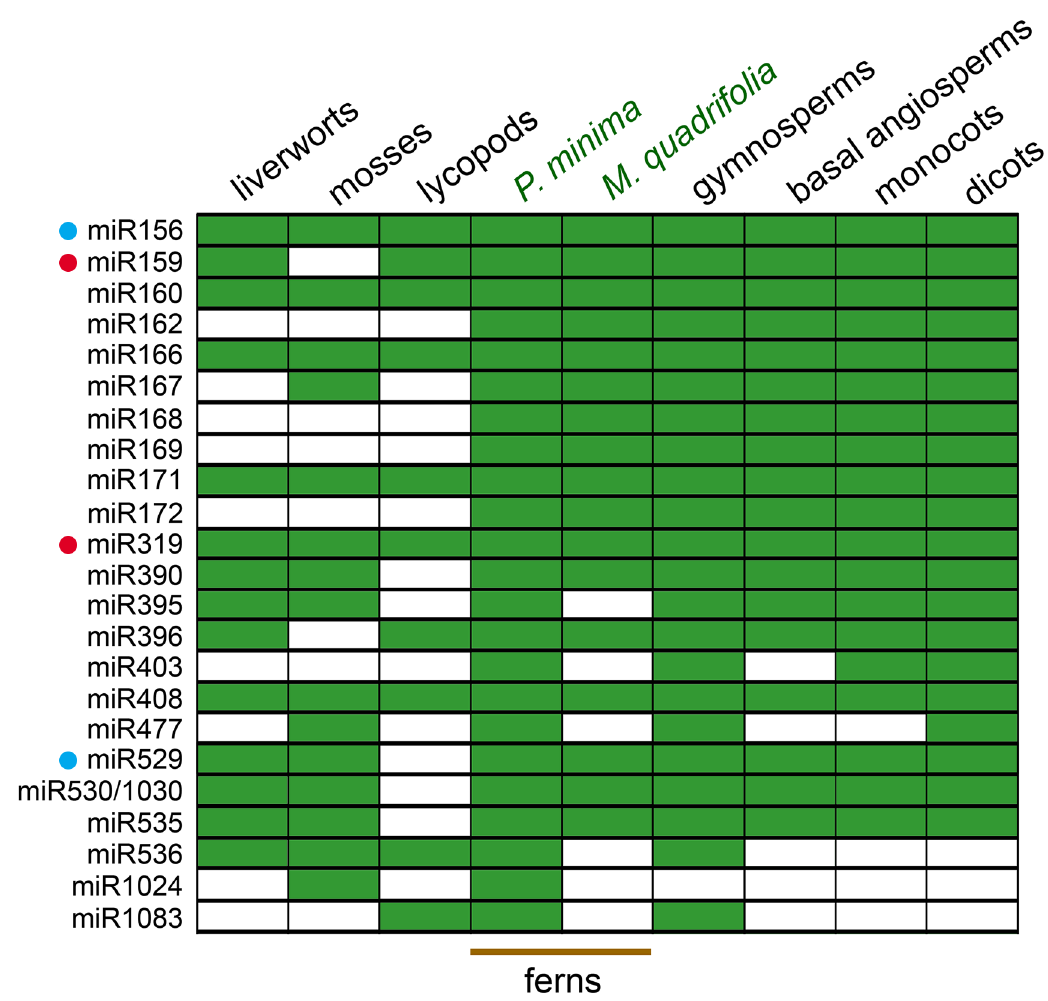
Fig 3. Phylogenetic distribution of conserved fern miRNAs. The grid indicatesthe presence(green)or absence (white) of miRNA families in liverworts ( M . polymorpha and/or P . endiviifolia ),mosses ( P . patens ), lycopods( S . moellendorffii ), ferns ( P . minima and M . quadrifolia )as well as gymnosperms, basal angiosperms, monocotsand dicots. For gymnosperms we took into account miRNAs of P . abies [6, 41], C . lanceolata [38] and T . mairei [39] and species reportedin [23]; for angiosperms we includedmiRNAs of speciesreported in [23] and in miRBase release 21.0 [31]. Pairs of miRNAs that can be consideredfrom the same family are indicatedby coloureddots. Note that miRNAs are not necessarily present in all membersof a group. Among liverworts,miR530/1030, miR529and miR536are only found in M . polymorpha , whilemiR156, miR395and miR535are only found in P . endiviifolia [36, 42, 43]. MiR403and miR529 are absent from most non-dicotangiosperms [44] and eudicots[32, 33], respectively.